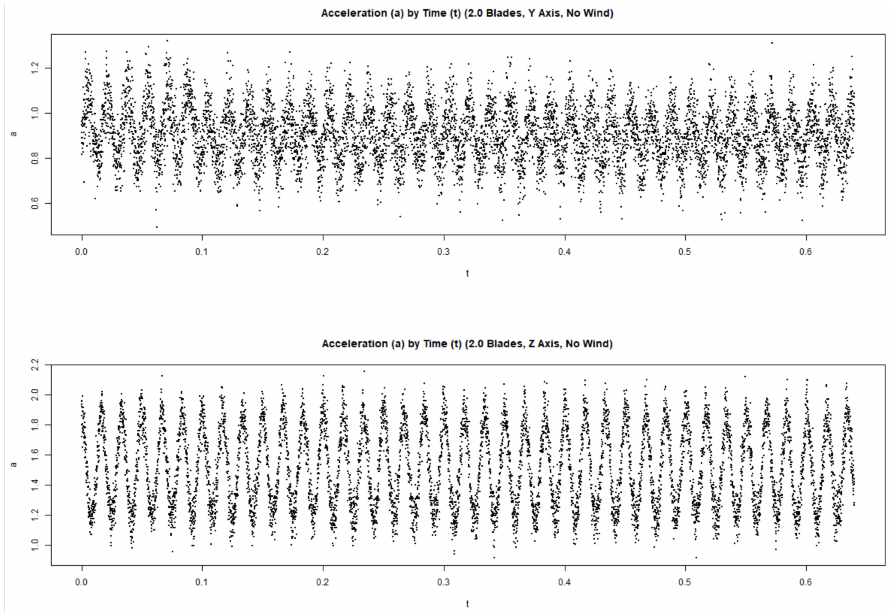
Figure 4. Acceleration signals recorded for the 2.0-blade (one blade missing) turbine.